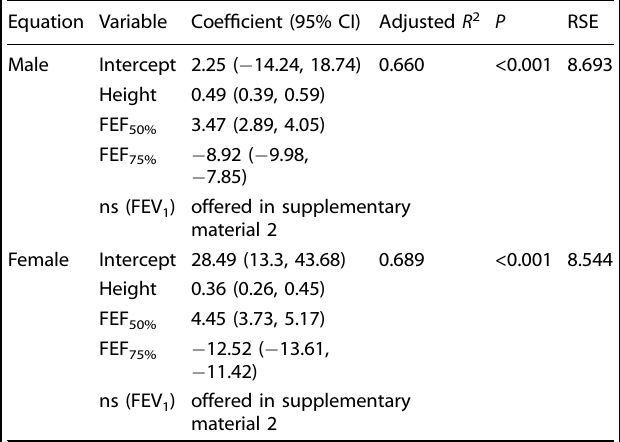
Table 4. Lung age estimation equations developed by the spline